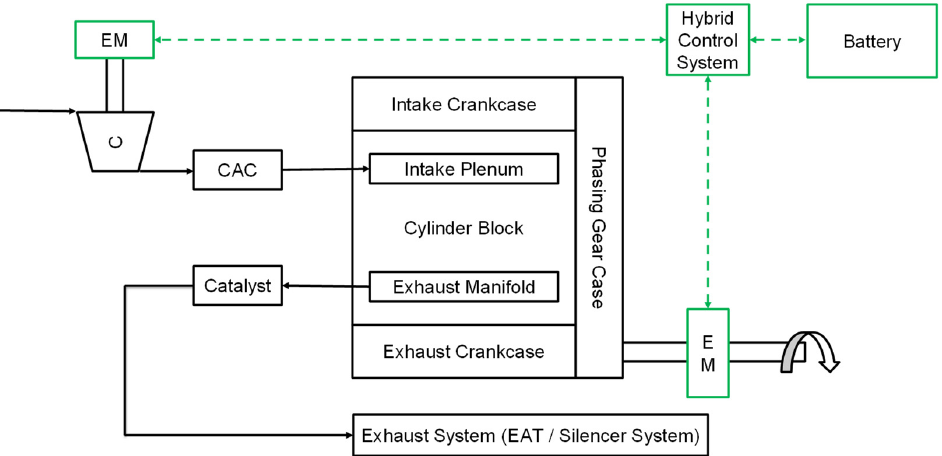
Figure 3. Schematic representation of OP2S engine configuration with electric compressor (C, top left), using electrical power transmission as the method of variable-speed drive. CAC: charge air cooler; EM: electric machine; EAT: exhaust aftertreatment.